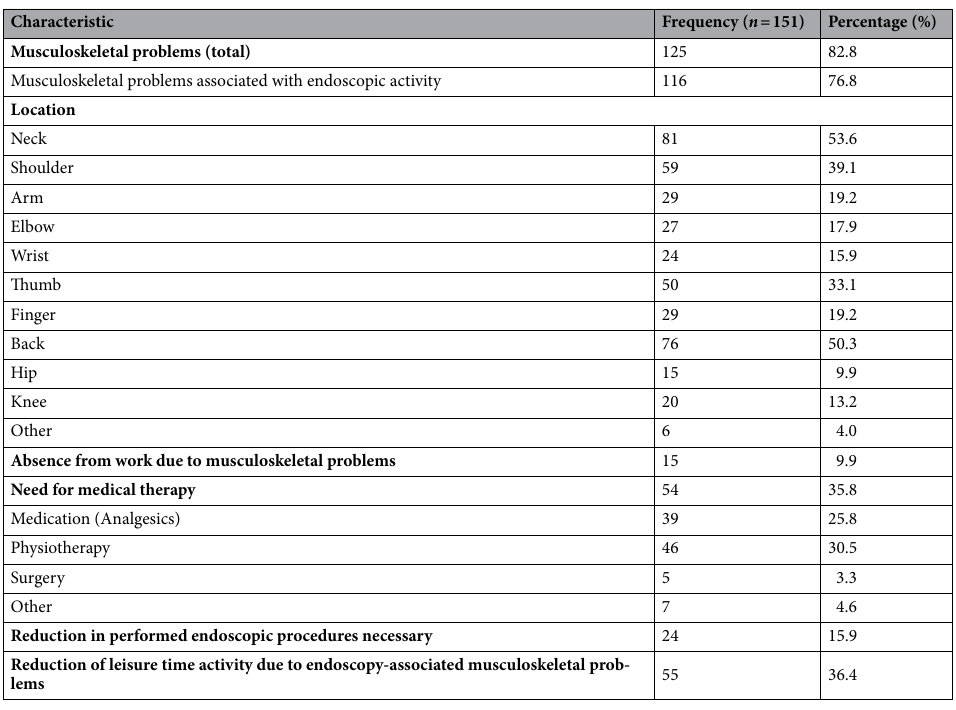
Figure 2. Musculoskeletal health disorder in German endoscopists by localization (%).